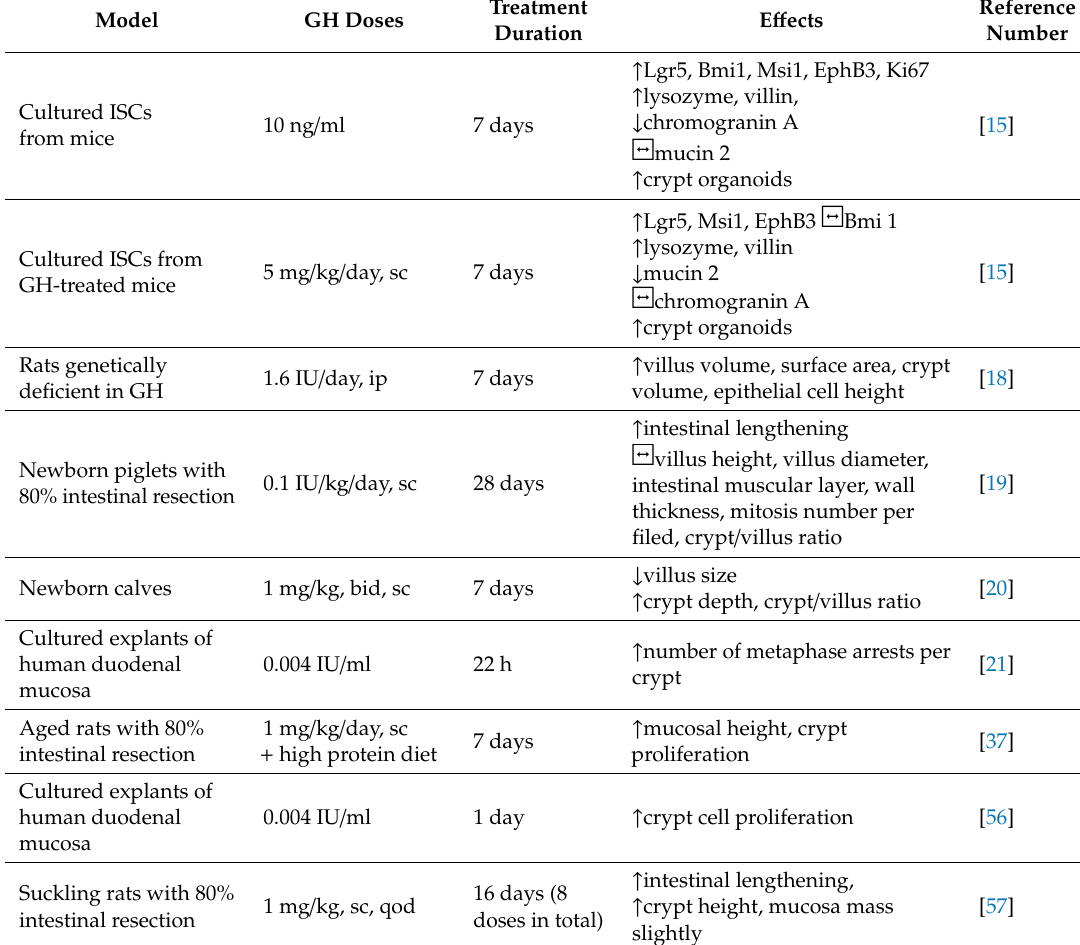
Table 1. Effects of growth hormone treatment on intestinal crypt cells and stem cells.